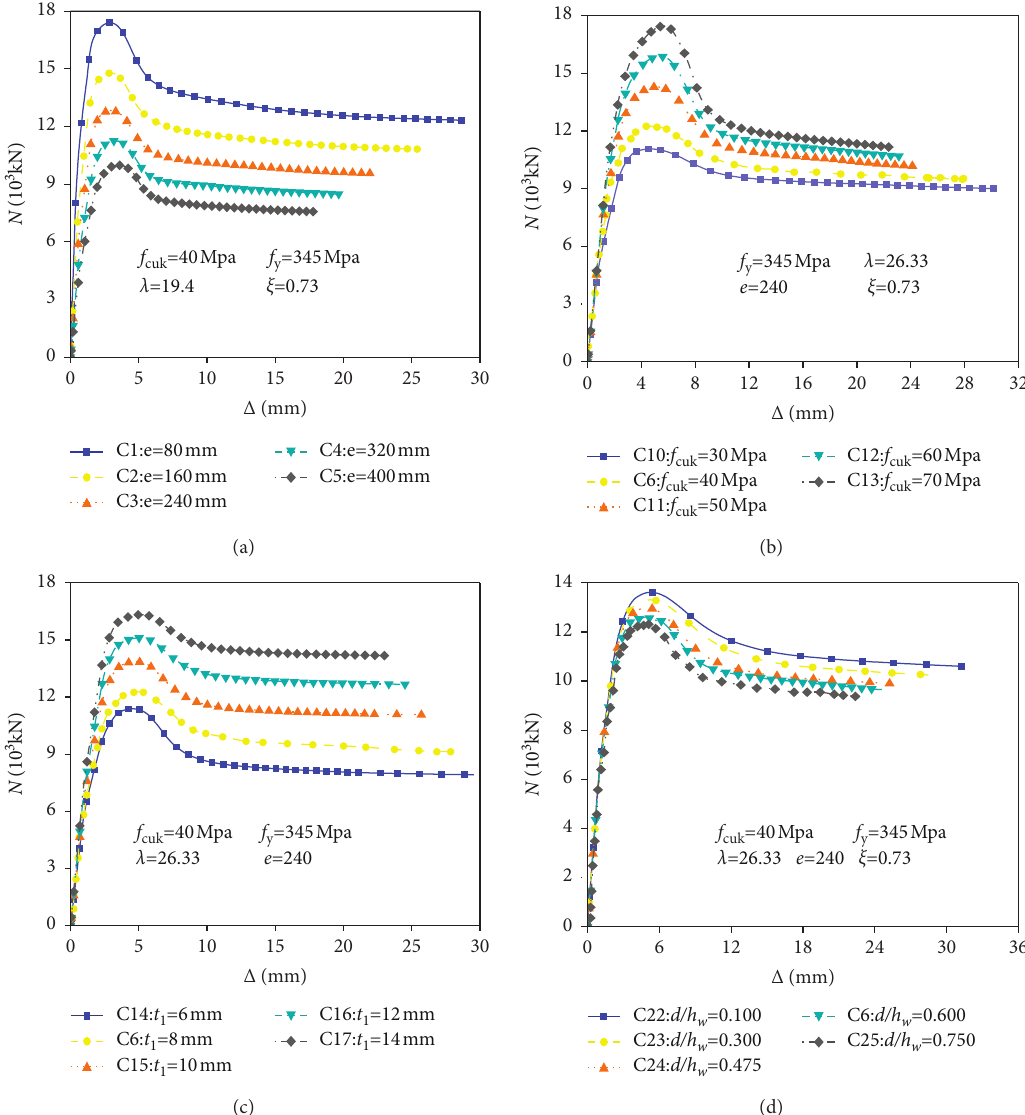
Figure 8: Comparisons of N - Δ curves of STHCCs with different parameters. (a) e . (b) f